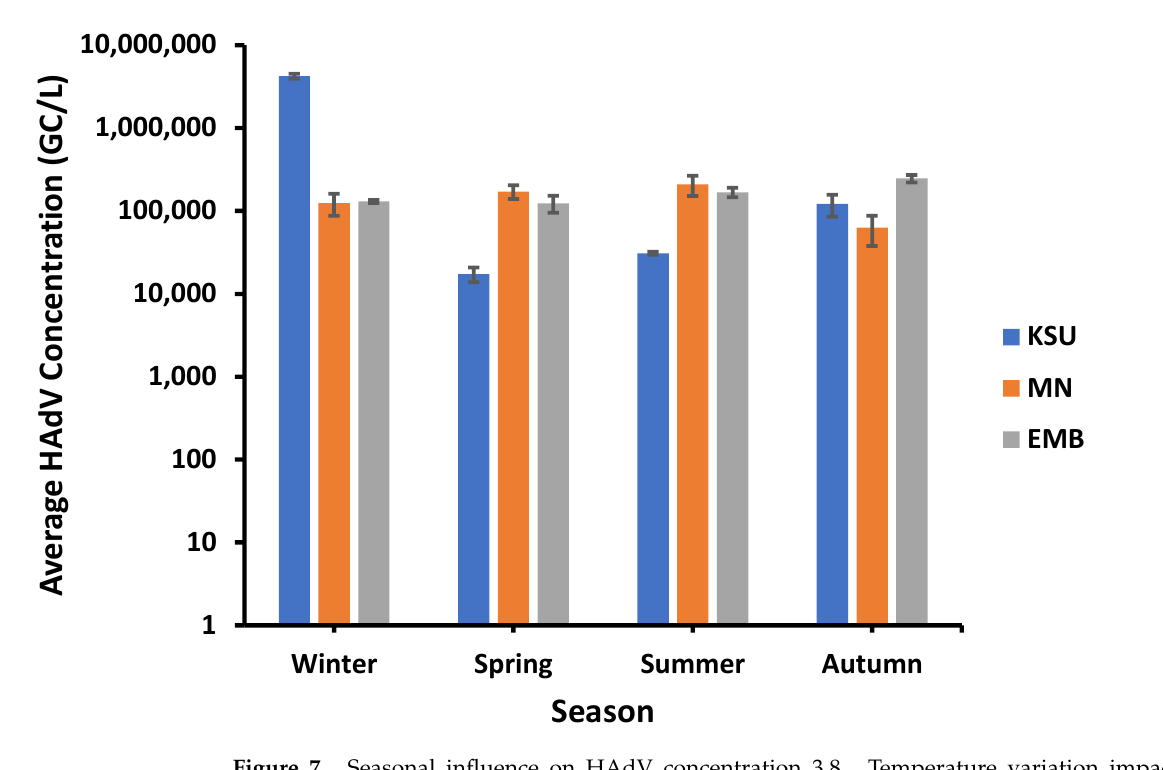
Figure 7. Seasonal influence on HAdV concentration 3.8. Temperature variation impact on HAdV concentration.